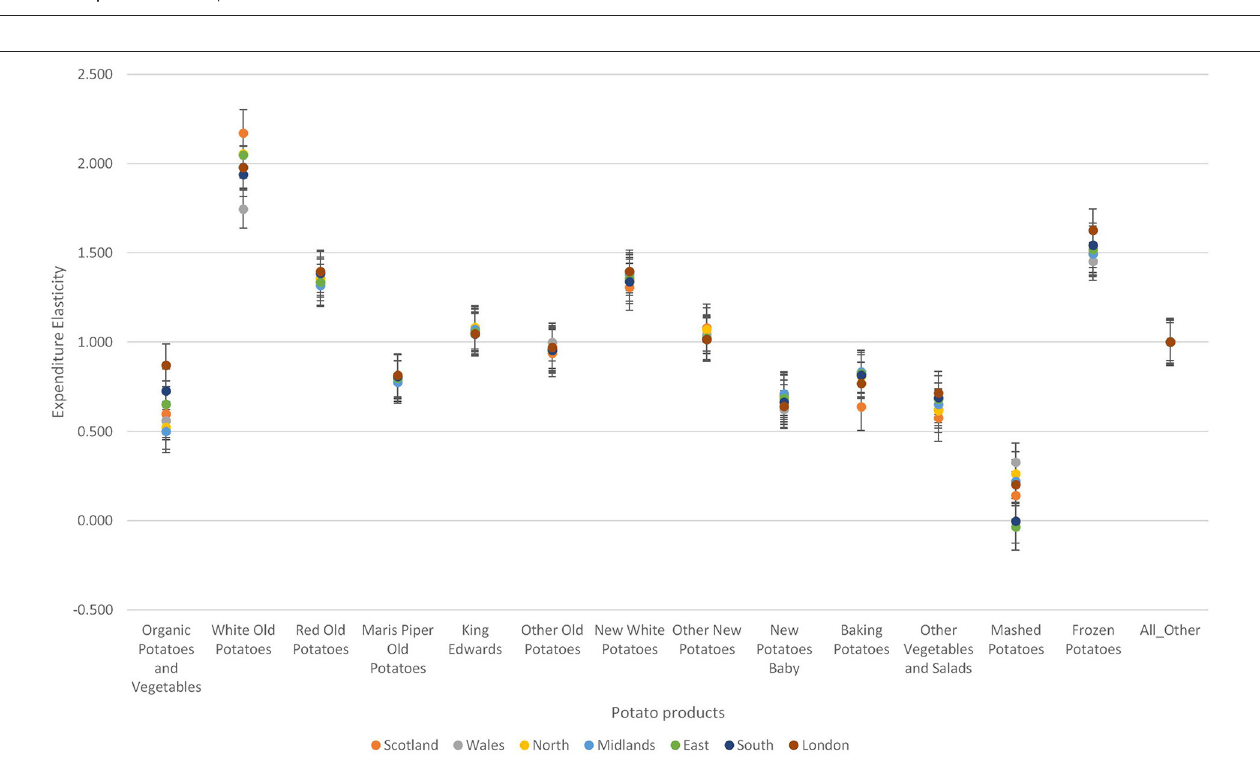
FIGURE 4 | Variations in expenditure elasticities across sexes.